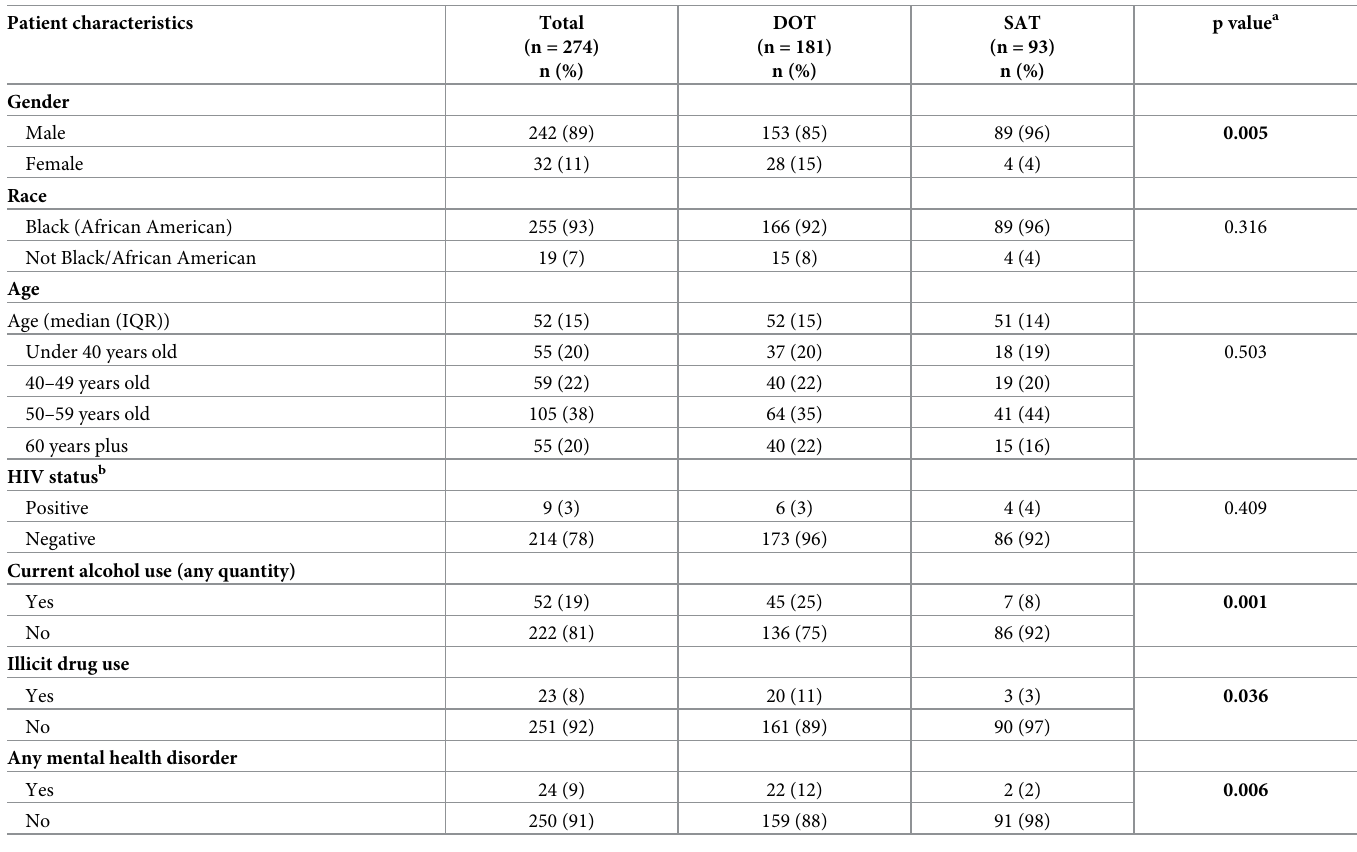
Table 1. Distribution of baseline characteristics of homeless adults treated for latent tuberculosis infection with four months daily rifampin regimen in Fulton County, Georgia (2014–2016). Patient